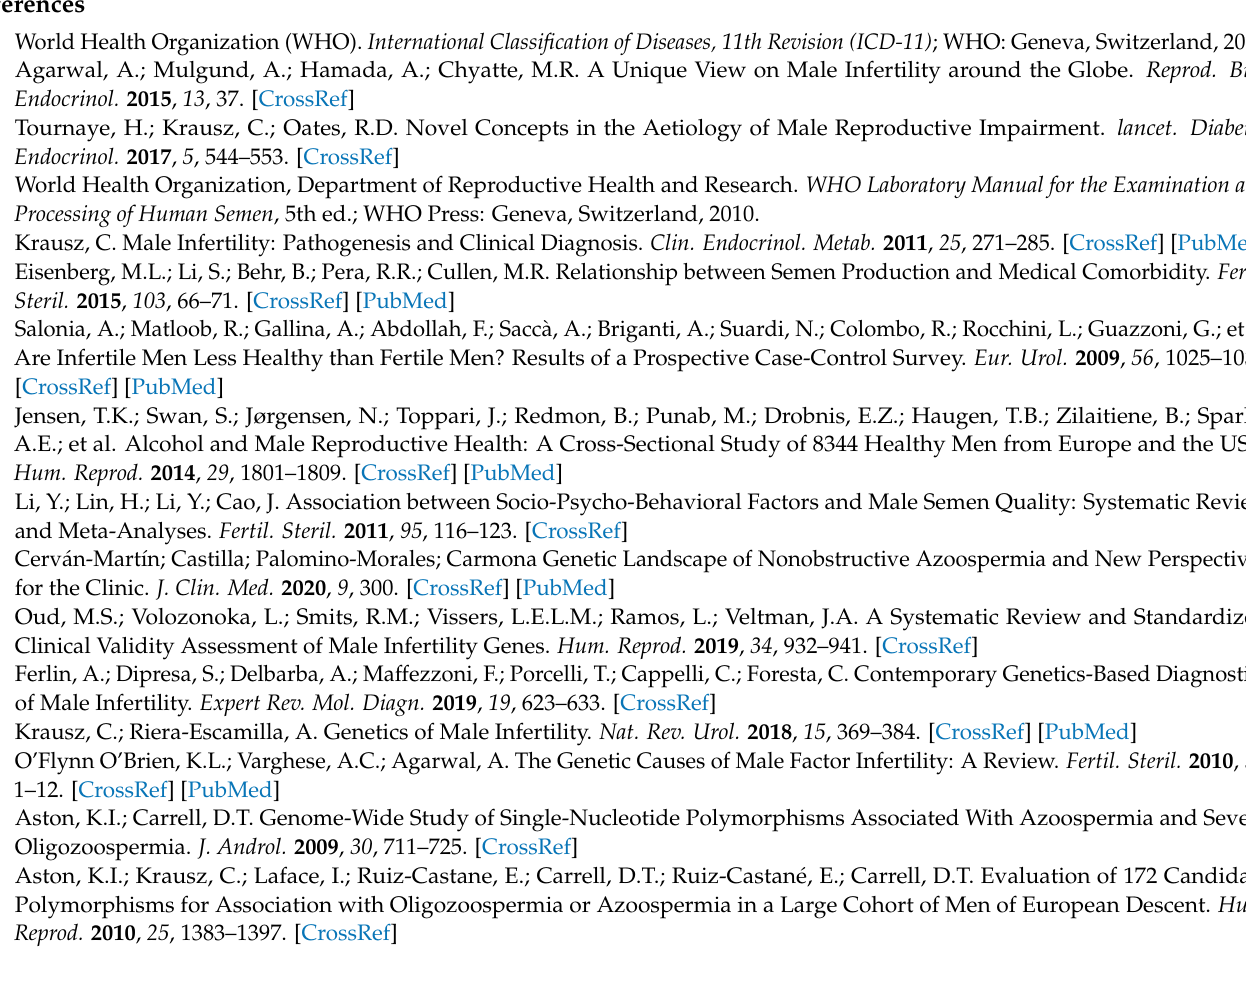
Table S4: SNPs reported to be associated with telomere length by previously published